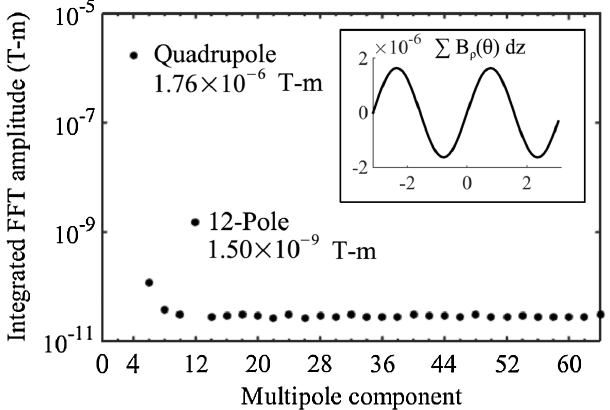
FIG. 7. Multi-pole moments of the prototype quadrupole field (inset) evaluated at the edge of the 0.1% good field region (0.072 mm from the center) and integrated through the longi- tudinal axis of the electromagnet. 4-pole is the quadrupole moment. The 12th, 20th, 28th, and higher order odd harmonics of the quadrupole moment result from truncating the infinite hyperbolic pole tips in 3-D. Other multi-pole components are a result of the finite mesh density and imperfect mesh symmetry of the FEM simulation.